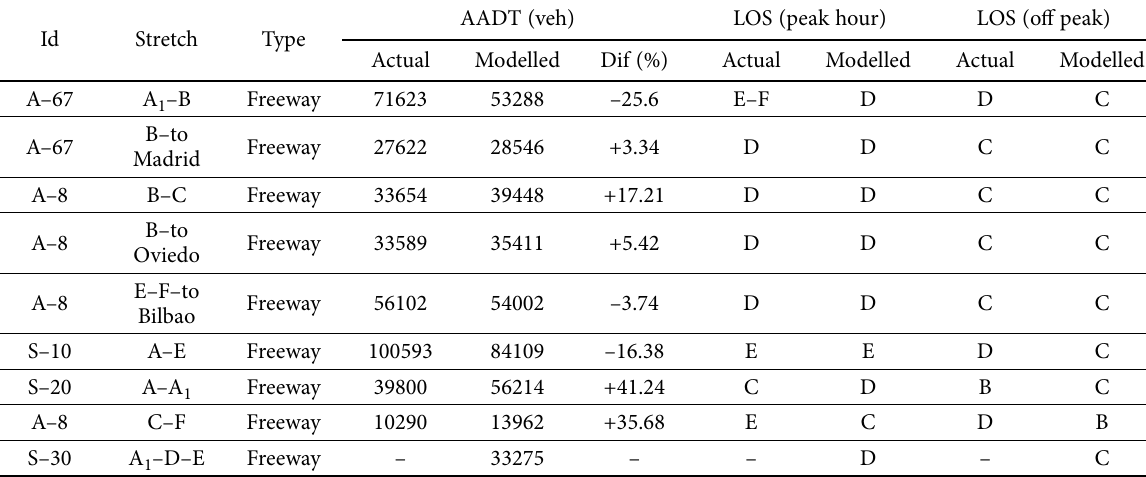
Table. Current and modelled AADT; Level of Service (LOS)